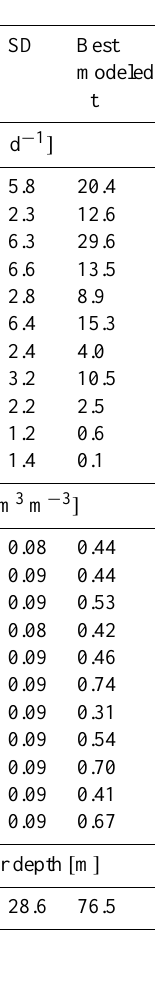
Table 6. Parameter ranges used for validation (all calibration runs with NSE > 0.15, bias < ± 20.0‰ δ 2 H and R 2 > 0.65) and param- eter set for the best modeled fit based on